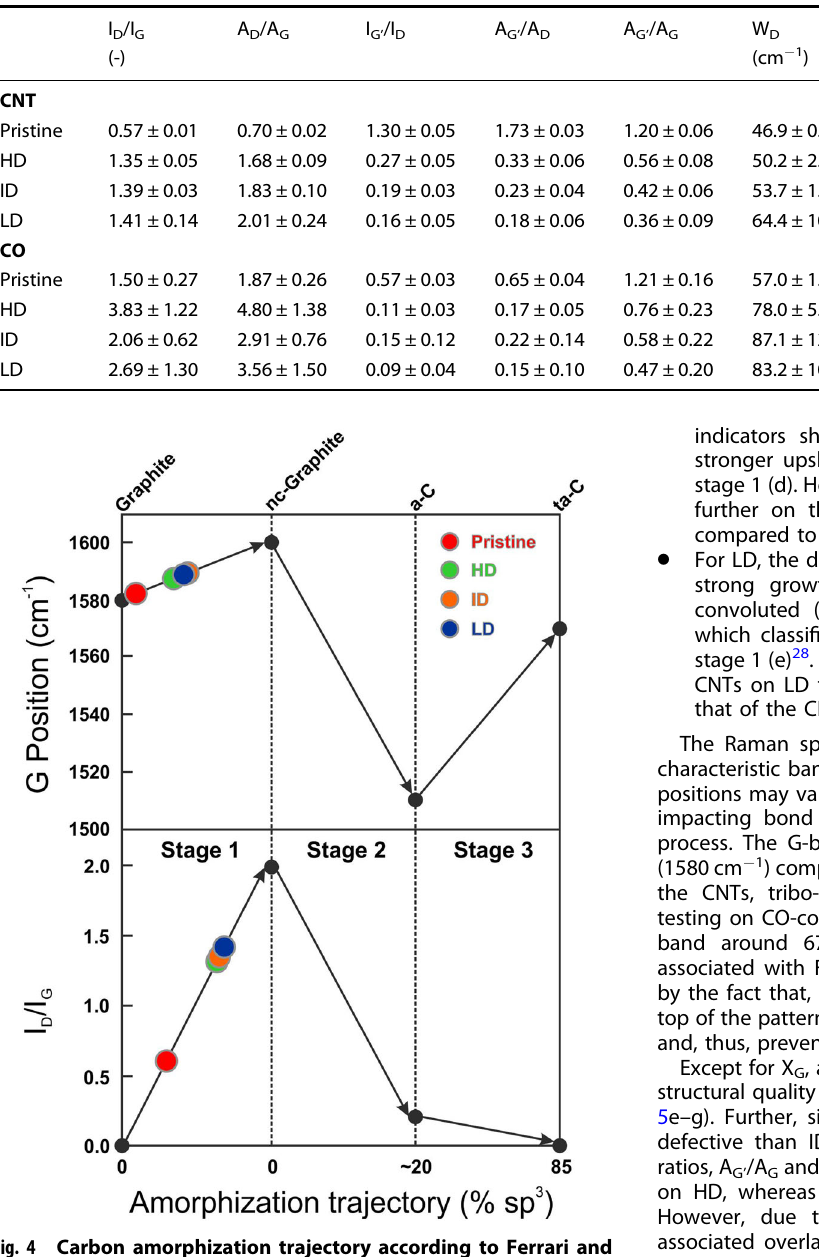
Table 1. Overview of the Raman indicators derived from the spectral features of the respective particles.